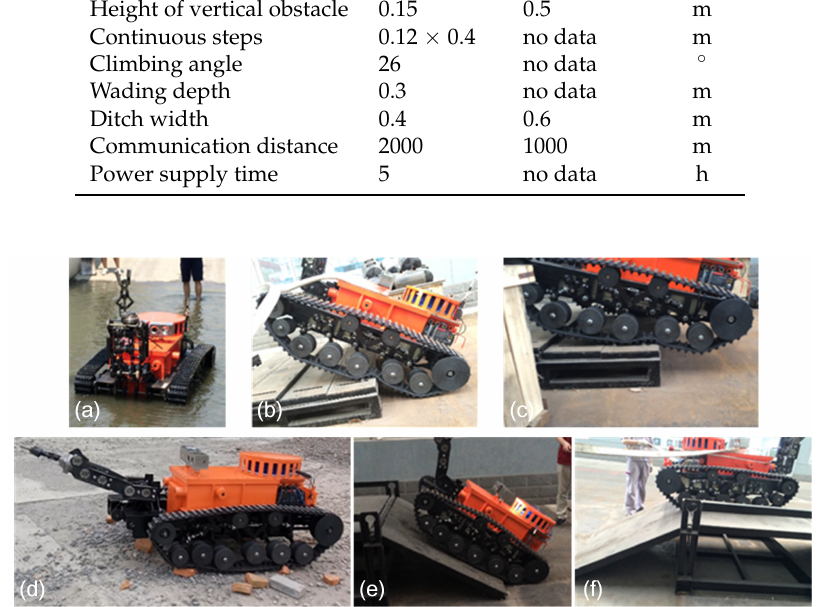
Figure 26. Test at the Changzhou site of Center of National Safety Approval and Certification. ( a ) shows that the robot was traveling and communicating in the water, where the deepest depth is more than 0.025 m. ( b , c ) show how the robot climbed the step, and the height of the step was about 15 cm. ( d ) shows that the robot was traveling on the gravel ground. ( e , f ) shows how the robot climbed a slope, and the slope was about 26 ◦